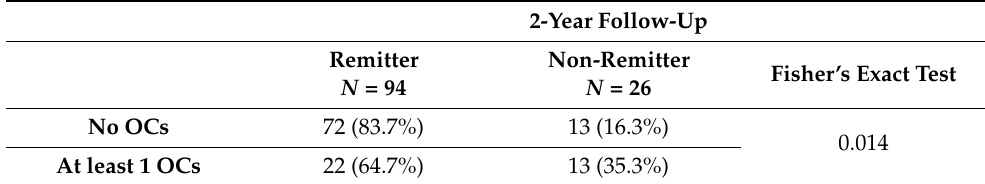
Table 2. Association between illness course at 2 years and OCs (N =